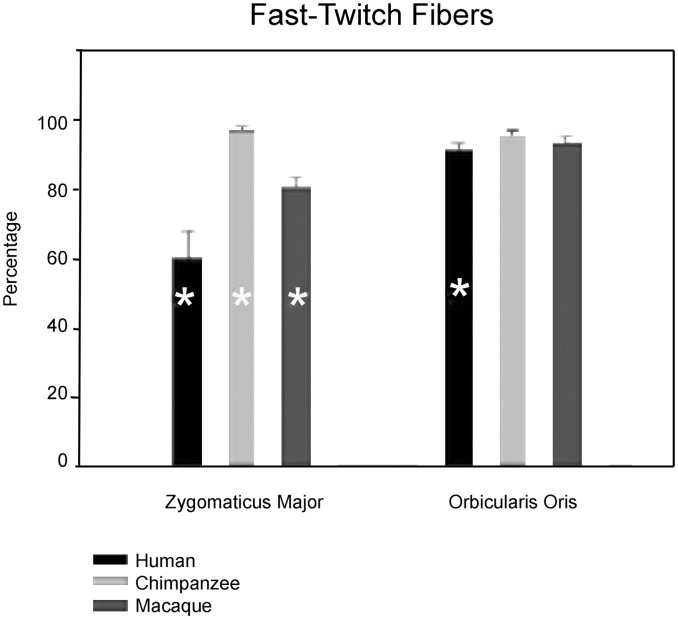
Percentages of fast-twitch myosin fibers in facial muscles.Results of one-way ANOVA and post-hoc Least Squares Difference testing in the zygomaticus major muscle indicate that chimpanzees had the highest percentage of fast-twitch myosin fibers and humans had the lowest (chimpanzee > macaque > human) at the p<0.05 level of statistical significance. In the orbicularis oris muscle, humans had the lowest percentage of fast-twitch fibers (chimpanzee = macaque > human) at the p<0.05 level of statistical significance. The presence of a “*” indicates that the group mean percentage was significantly different from the other groups. Means with SEM are shown.